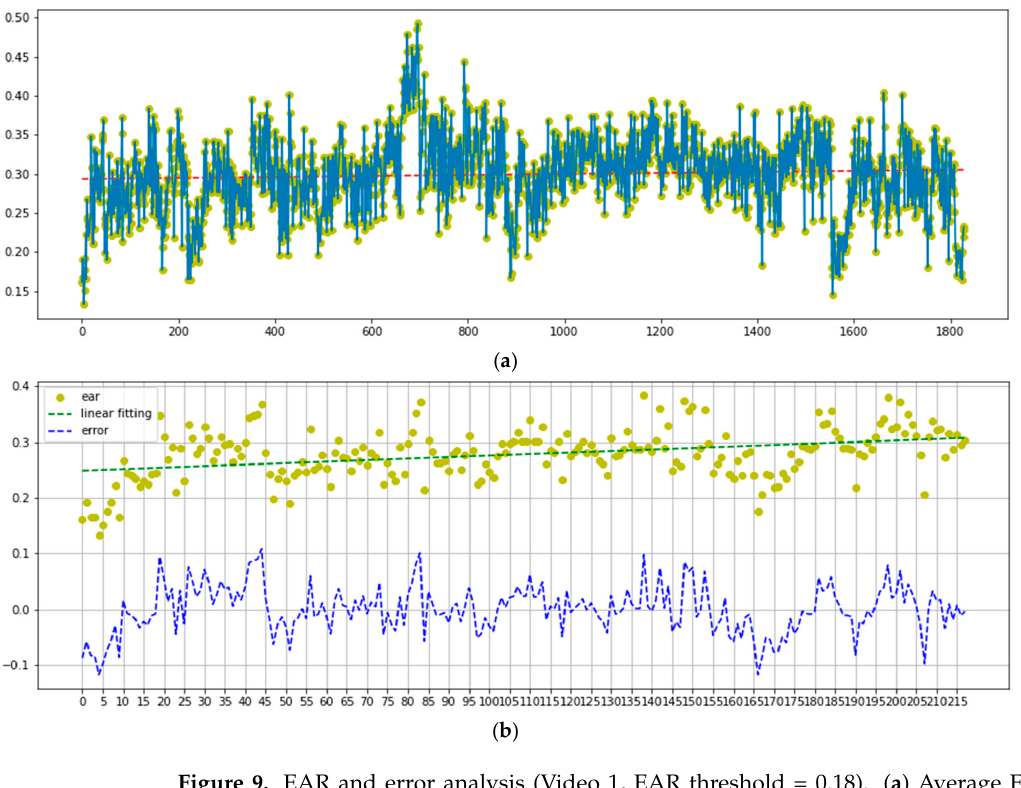
Figure 9. EAR and error analysis (Video 1, EAR threshold = 0.18). ( a ) Average EAR. ( b ) Error and EAR.